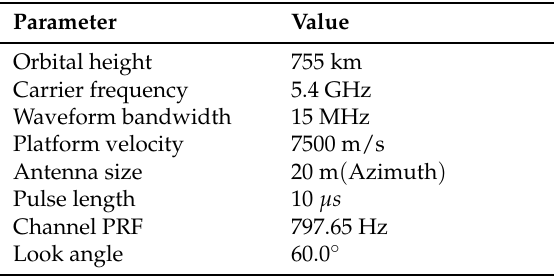
Figure 4. Range compressing results of up (positive modulation rate) and down (negative modulation rate) chirps using filter matched to up chirp. Parameters are taken from Table 1. The orange solid line shows the matched compression result. Whereas the blue dashed line shows the smearing compression result with filter mismatched. Table 1. Simulation